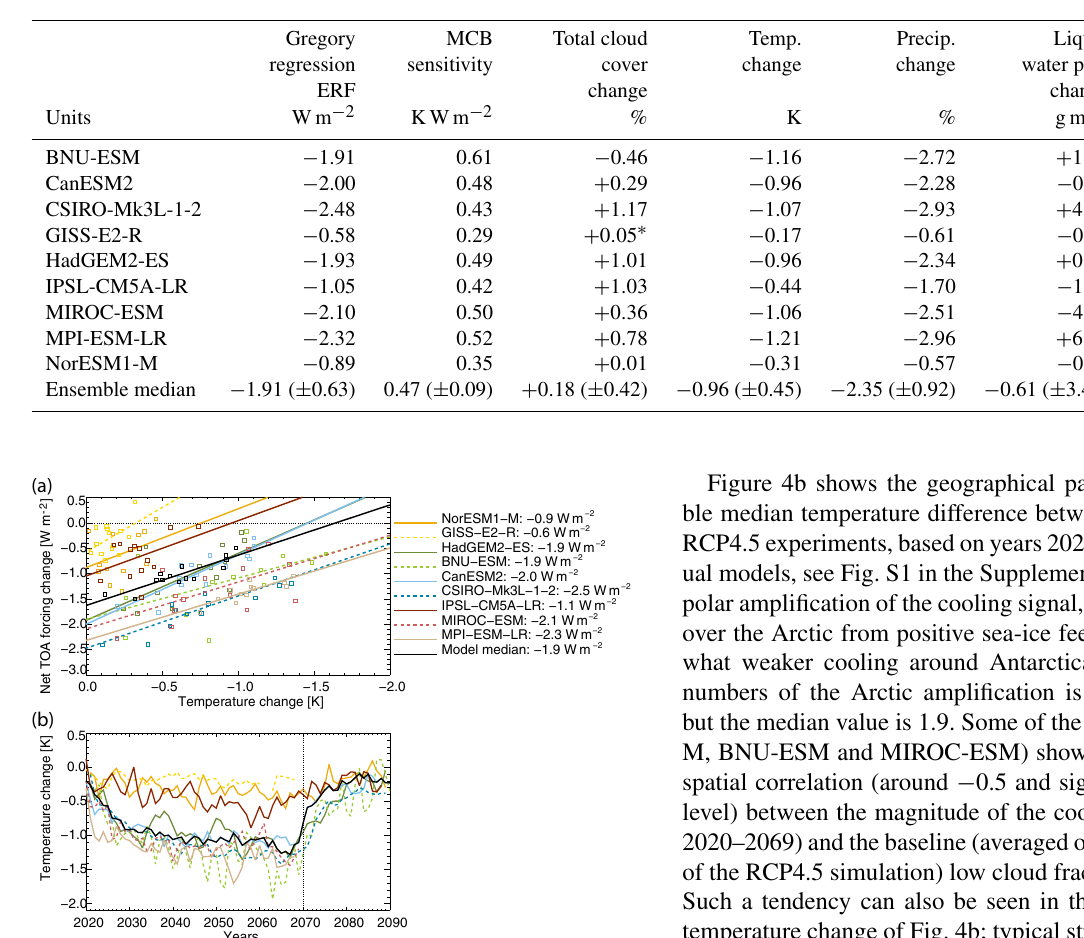
Table 3. G4cdnc minus RCP4.5 difference (based on years 2020–2069) in the key variables, including the effective radiative forcing as estimated in Fig. 3a). An asterisk denotes that the change is not significant at the 95% level by the Kolmogorov-Smirnov test.